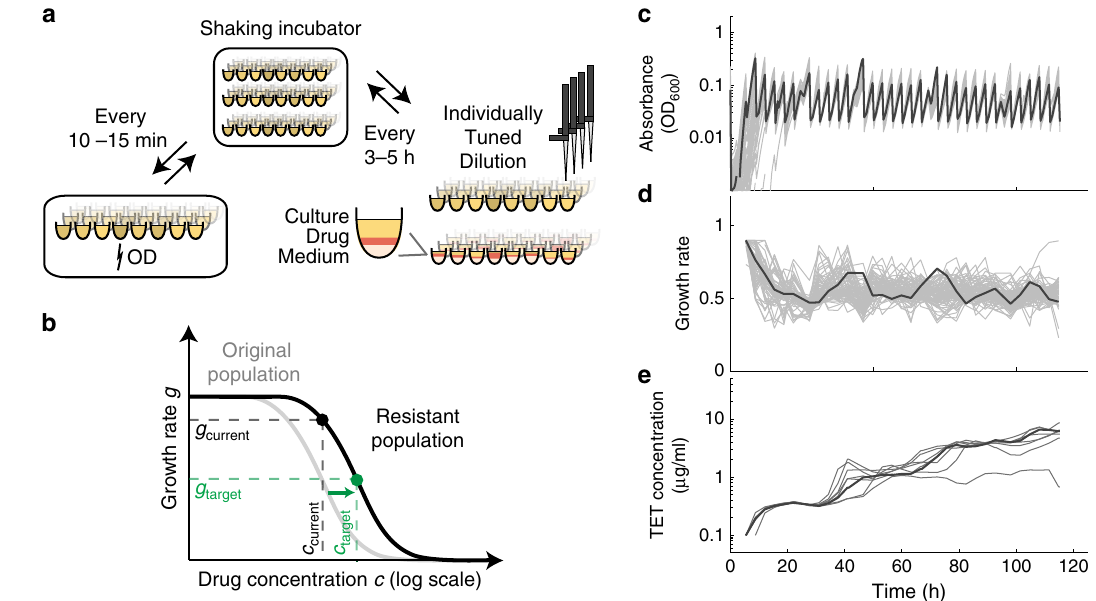
Fig. 1 Automated highly controlled lab evolution leads to reproducible fast evolution of antibiotic resistance. a Schematic of lab evolution protocol. 96- well plates are shaken in an incubator, optical density (OD) is measured every 10 – 15 min in a plate reader, and the cultures are diluted and transferred